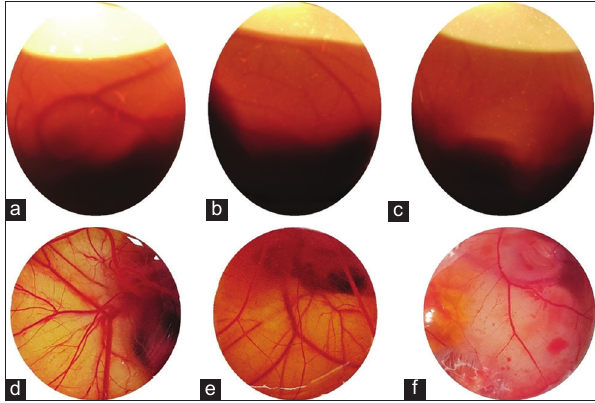
Figure-4: In ovo antiangiogenesis activity of Typhonium flagelliforme ethanol extract, natural canine interferon and recombinant canine interferon (rCaIFN) single or in combinations on 11 days old embryonic egg. The upper part (a-c) is the candling observation while the lower part (d-f) is the direct observation of the blood vessel development by breaking the eggshell. The left side (a and d) is the control group without treatment, the center (b and e) is treated with rCaIFN only, and the right side (c and f) is treated with the combination of T. flagelliforme ethanol extract and